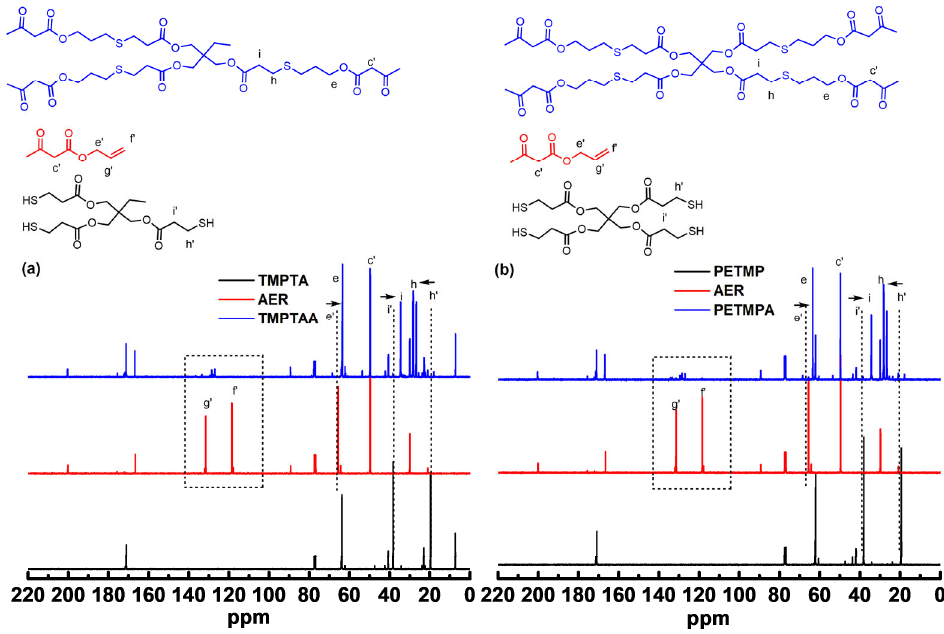
Figure 2. ( a ) 13 C NMR of TMPTA, AER and TMPTAA, ( b ) 13 C NMR of TMPTA, AER and PETMPA.